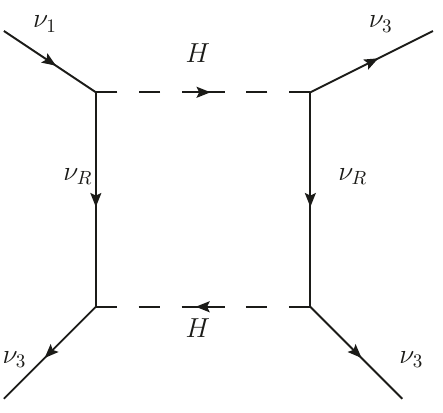
Figure 1 . Visible decay of active neutrinos to other active neutrinos in the (cid:23) 2HDM set up through a box diagram: (cid:23) 1 ! 3 (cid:23) 3